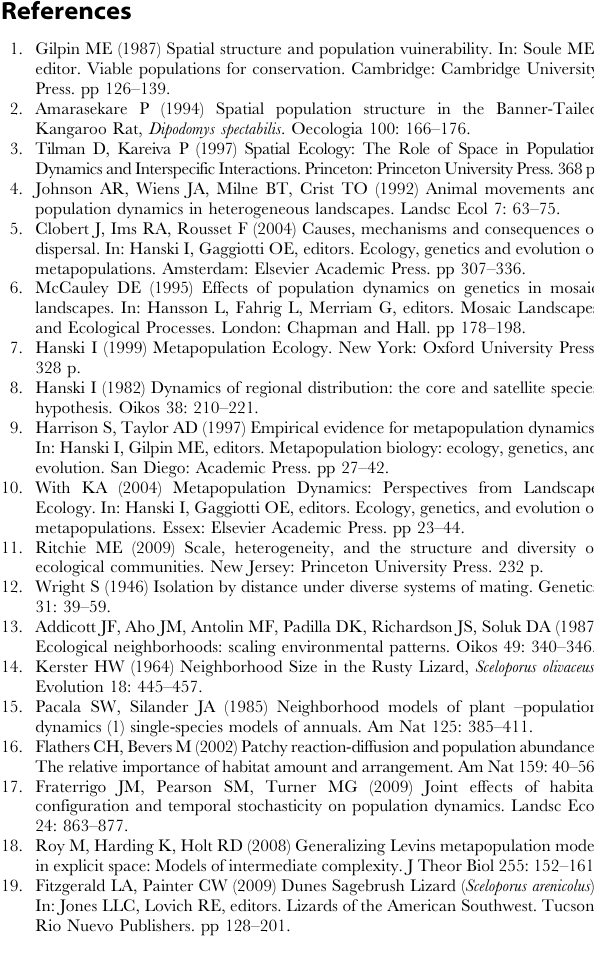
each pitfall trap across sites. Blowout counts for the depth metric were 10, 8, 11, 19, 18, and 8 for sites 1–6, respectively. Protocol S1 Demographic parameter estimation. Table S4 Model ranking of Cormack–Jolly–Seber (CJS) mark–recapture models estimating apparent survival ( s ) and recapture probability ( p ) for S. arenicolus across 6 sites from 2005–09. Table S5 Model-averaged estimates of apparent surviv- al for female and male S. arenicolus across 6 sites from 2005–09 derived using Cormack-Jolly-Seber (CJS) mark- recapture models. Table S6 Sex-specific or time-variant (depending on model ranking) estimates of recapture probability for S. arenicolus across 6 sites. Table S7 Model ranking of Pradel mark–recapture models estimating apparent survival ( s ), recapture probability ( p ), and recruitment ( f ) for S. arenicolus across 6 sites from 2005–09.